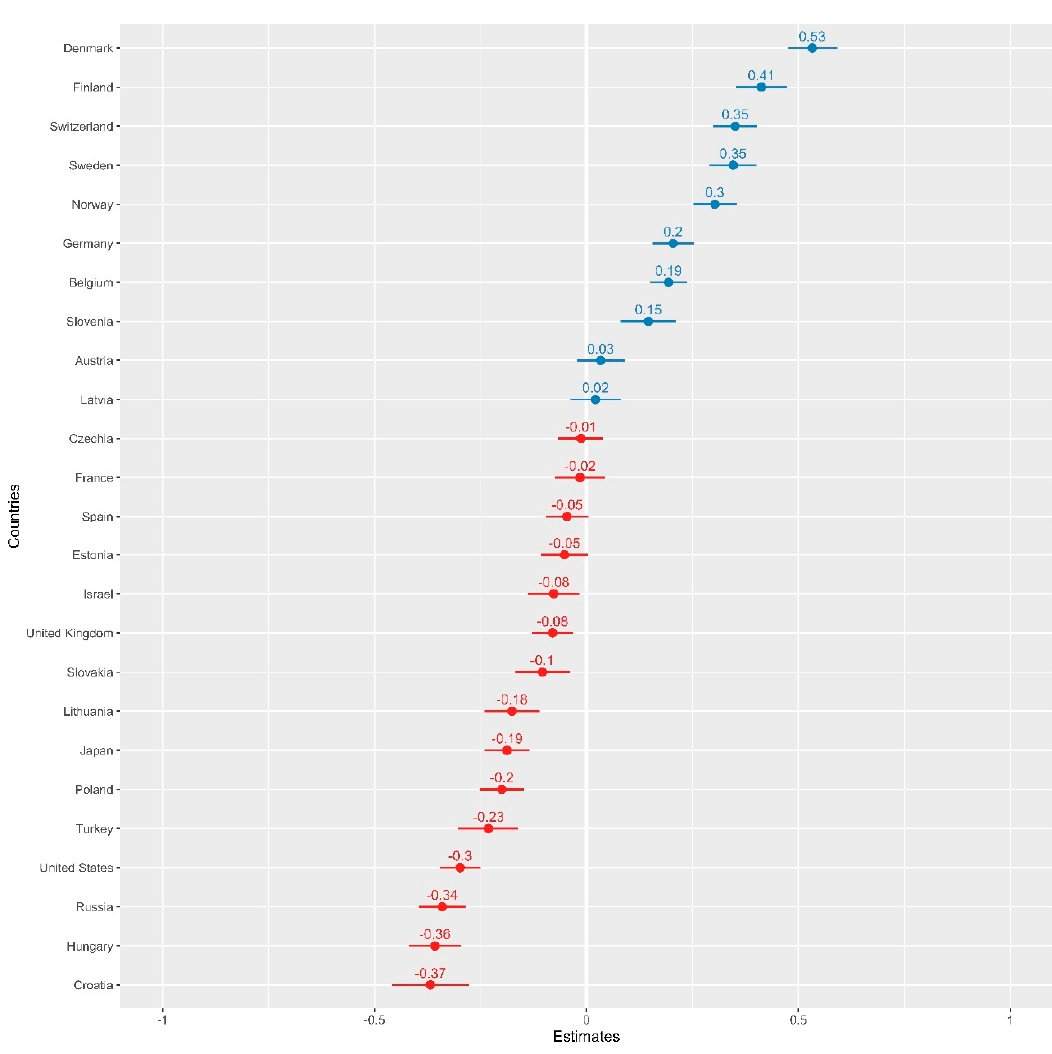
Figure 1. Effect of country-specific random intercepts on job preference orientations (based on Model A1, Table 1).